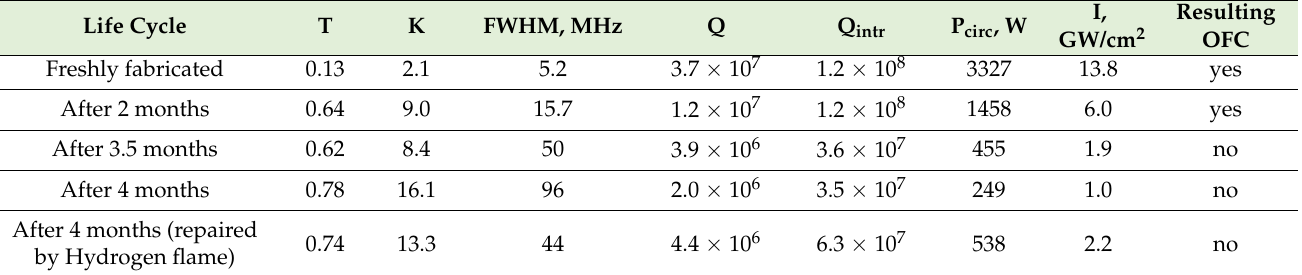
Table 1. Results of characteristics calculations for 170 µ m SiO 2 microsphere resonator versus life